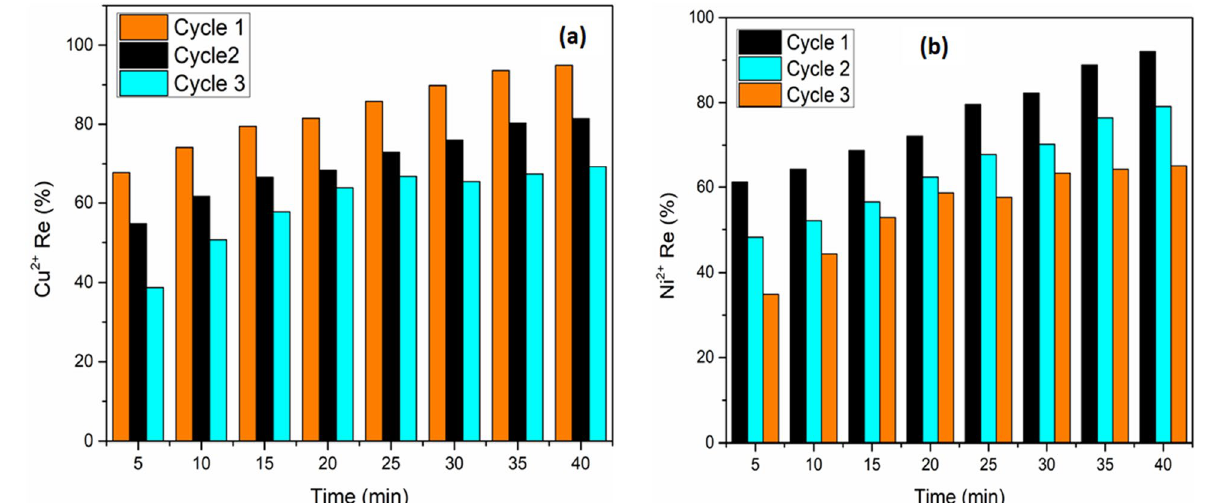
Figure 12. Maximum removal efficiency with reuse of the generated AGWTR for ( a ) Cu 2+ and ( b ) Ni 2+ removal using ADS/EC process. (AGWTR = 1 g; Cu 2+ and Ni 2+ = 20 mg L −1 at T = 30